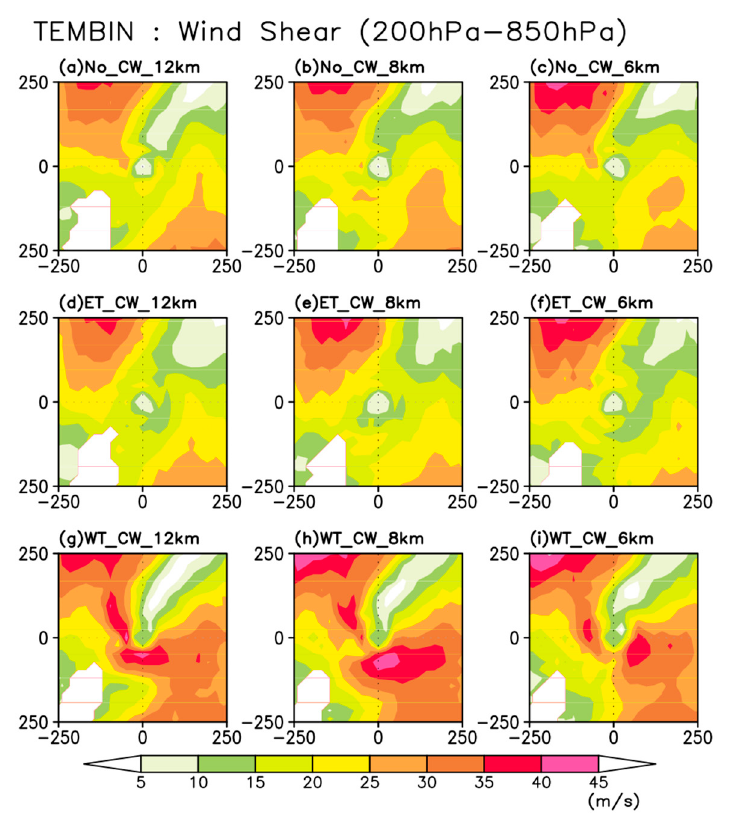
Figure 9. The 12-h averaged wind shear(200 hPa–850 hPa) in the inner region of TC (250 km × 250 km) over periods (48~60 h) in ( a ) No_CW_12 km, ( b ) No_CW_8 km, ( c ) No_CW_6 km, ( d ) ET_CW_12 km, ( e ) ET_CW_8 km, ( f ) ET_CW_6 km, ( g ) WT_CW_12 km, ( h ) WT_CW_8 km and ( i ) WT_CW_6 km experiment of Typhoon Tembin.